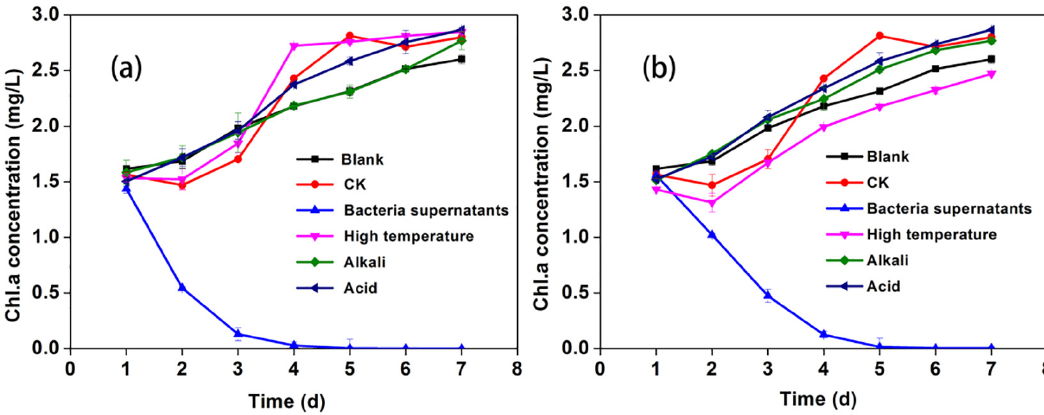
Figure 8. The effects of bacterial supernatant treated with different methods on chlorophyll-a of Microcystis aeruginosa. ( a ) strain 39 # and ( b ) strain 91 # .